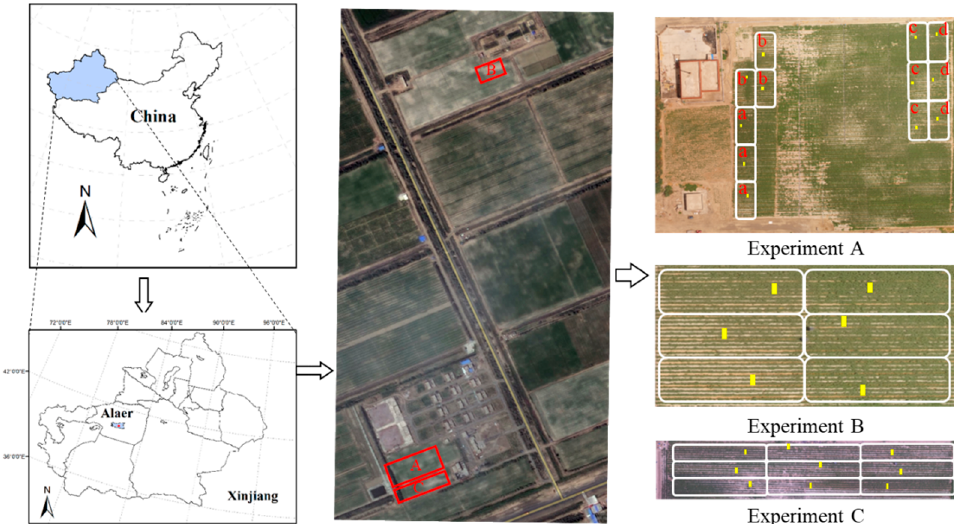
Figure 1. Location of the Alaer Irrigation Experiment Station and general situation of the experimental area (the red rectangles were the locations of the three test areas, the white rectangles were the different treatment areas in each test area and the yellow rectangles were the ground LAI measurement squares, and a/b/c/d in experiment A were present the four different planting modes).